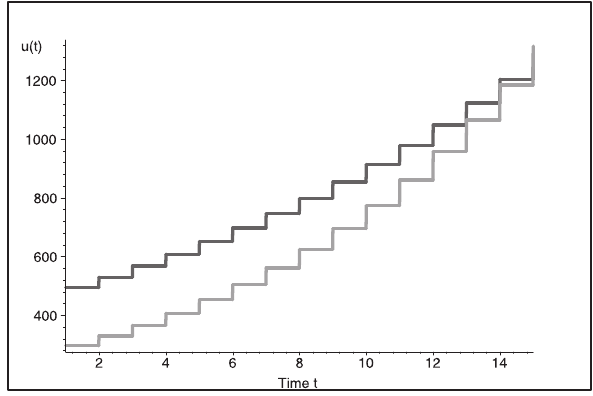
Figure 2. Players’ strategies: dark—cooperation, light—Nash equilibrium.